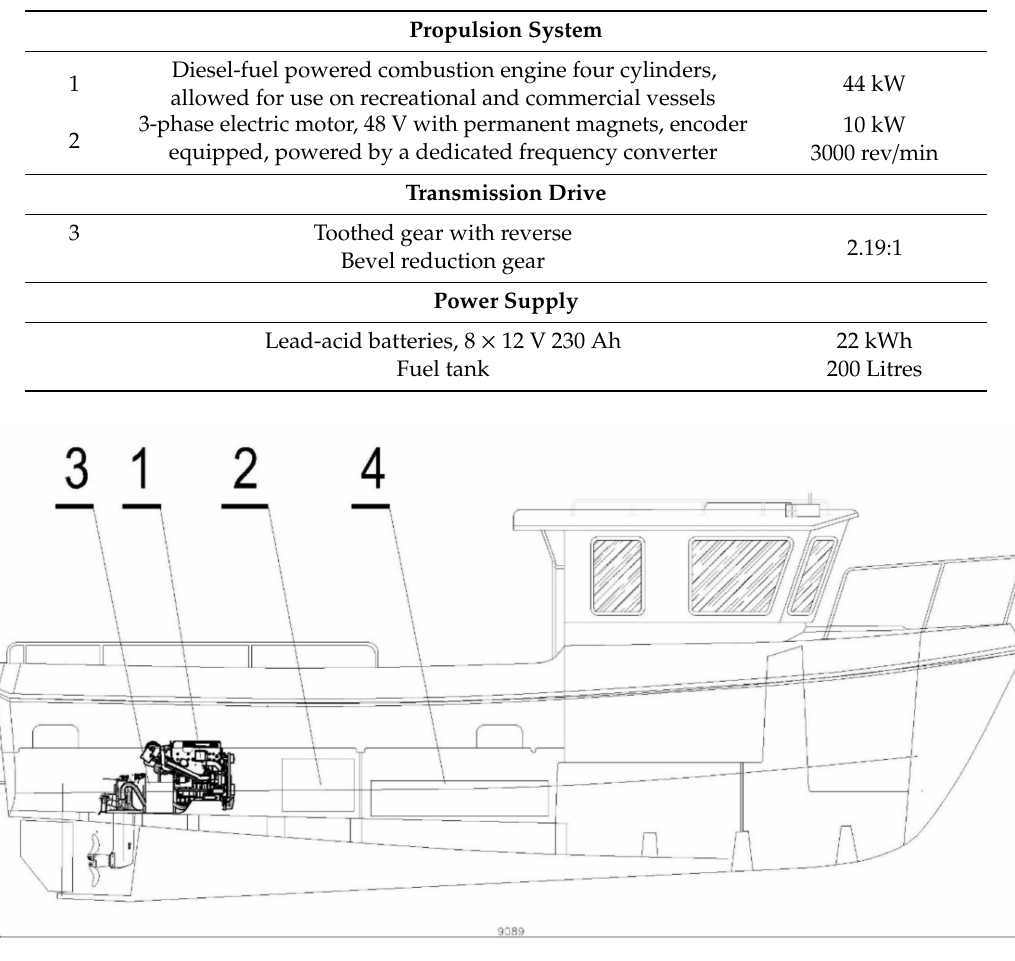
Figure 7. Conrad-900 vessel after retrofitting; 1—engine, 2—fuel tank, 3—electric motor / generator module,